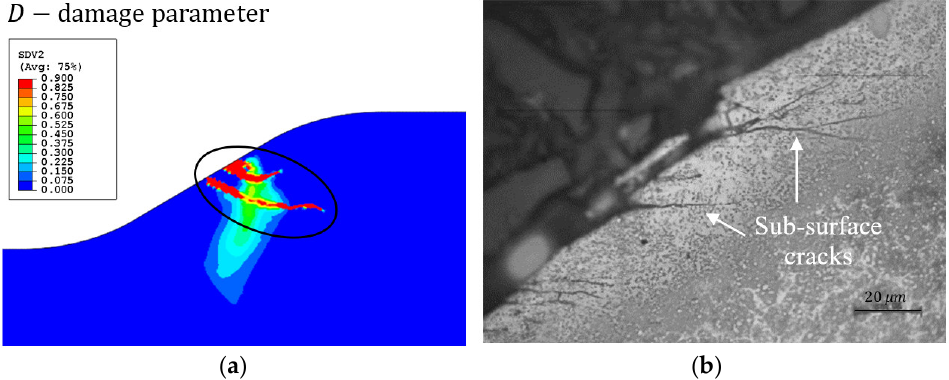
Figure 7. ( a ) Map of the damage variable, D , at the end of the crack initiation simulation, representing the crack generation beneath the spall edge surface, where is used as the effective stress in Equation (4). In the simulation of the crack propagation, only the initial part of the crack was taken. ( b ) Microscopic image of a metallographic cross-section through a spall front, etched with nital.